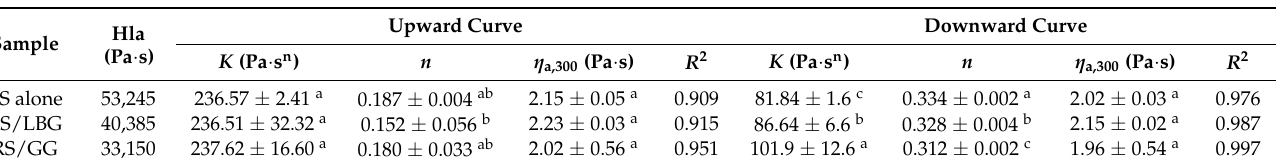
Table 4. The steady flow fitting parameters of RS alone, RS containing locust bean gum (RS/LBG), and RS containing guar gum (RS/GG) *.